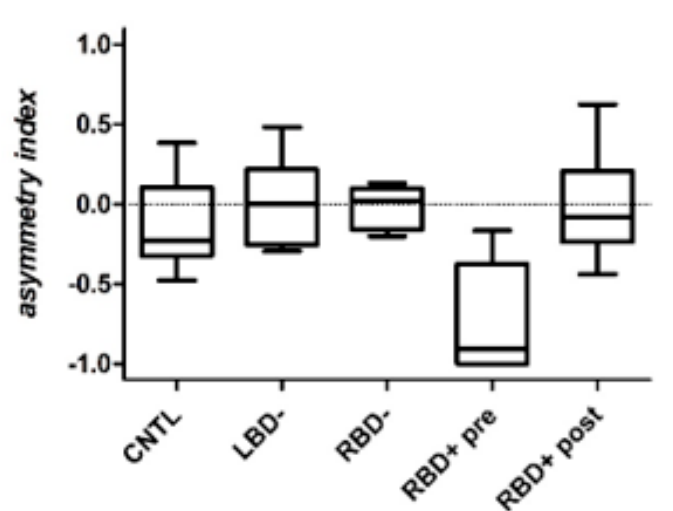
Figure 1. Group asymmetry index data during free exploration of the map of France for each of the three control groups and for the RBD + group before and after caloric vestibular stimulation (CVS). Whiskers represent 1.5 X IQR.